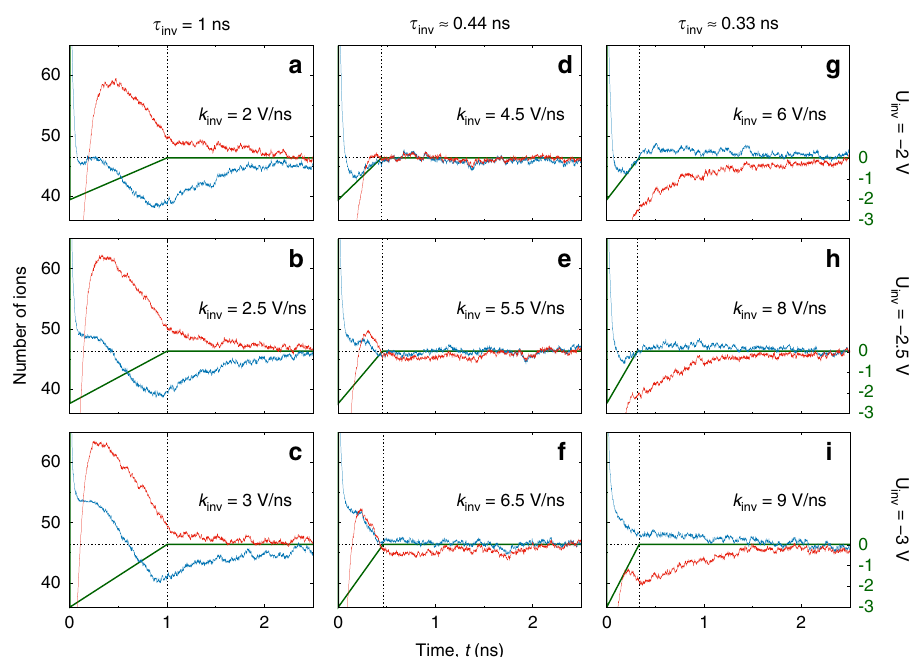
Fig. 5 Discharging via voltage inversion. Potential difference and the number of particles for a few values of the inversion voltage U inv (measured with respect to the bulk electrolyte) and slope k inv with which the voltage reverses to approach U = 0, see eq. (10). The rows correspond to the same values of U inv , as indicated in the plot, and the columns to (approximately) the same values of co and counterions in the pore are shown by green, red, and blue lines, respectively. The thin horizontal lines denote the equilibrium numbers of co and counterions at U = 0. The optimal discharging parameters, minimizing the discharging time, are U inv = − 2.5 V and τ inv ≈ 0.4 ( k inv = 5.5 V/ns, cf., Fig. 6), corresponding to the middle of the nine panels. In all plots the ion diameter a = 0.5 nm, the pore width w = 0.6 nm and the pore length ℓ = 12